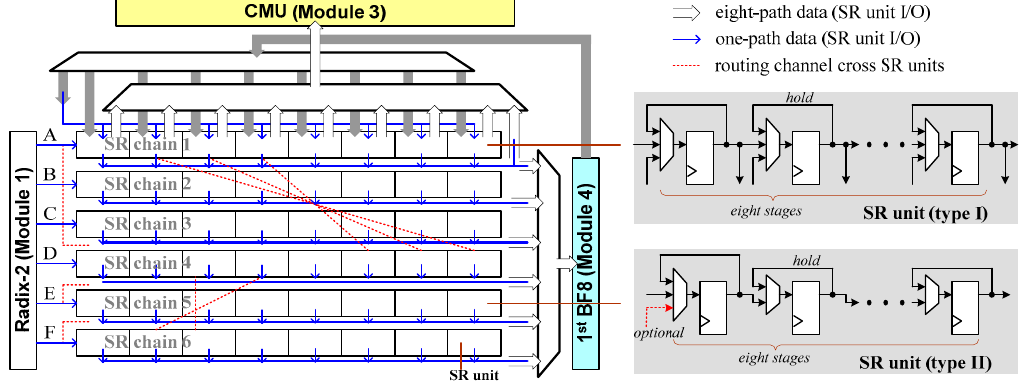
Figure 11. Block diagram of Module 2 (sorting buffer).